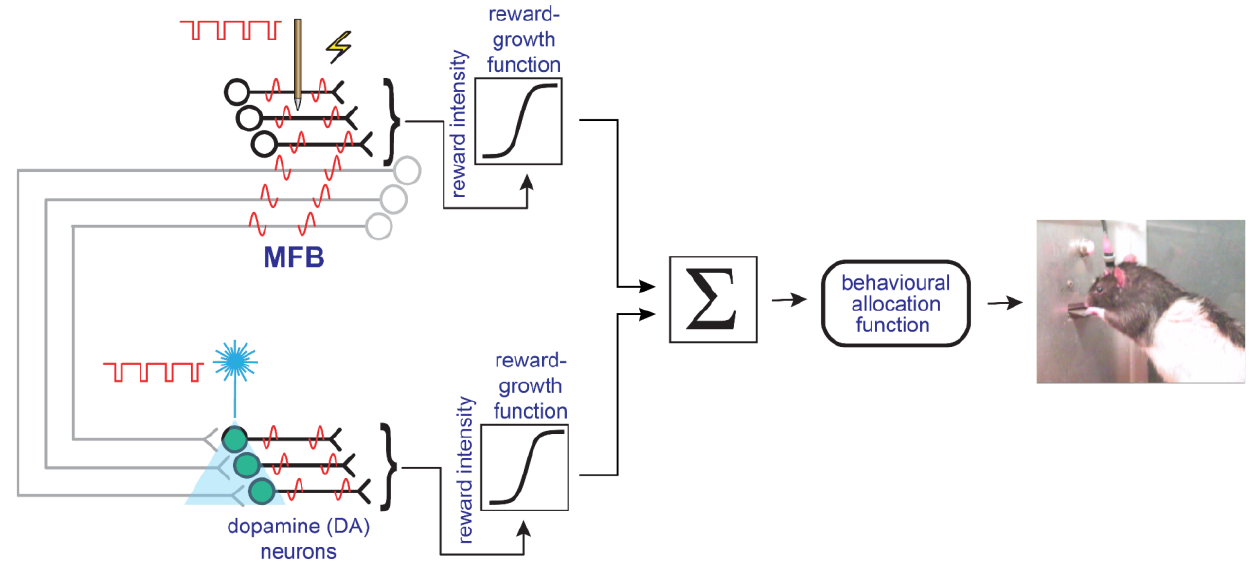
Figure 4. The convergence model simplified. Myelinated, non-dopaminergic axons and midbrain dopamine neurons provide converging inputs to the final-common path for reward evaluation and pursuit. From [16].